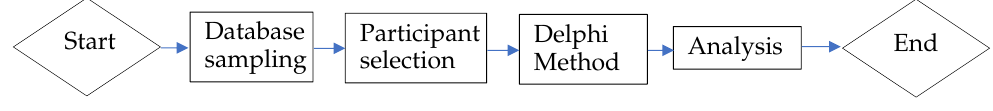
Figure 2. Database evaluation process.